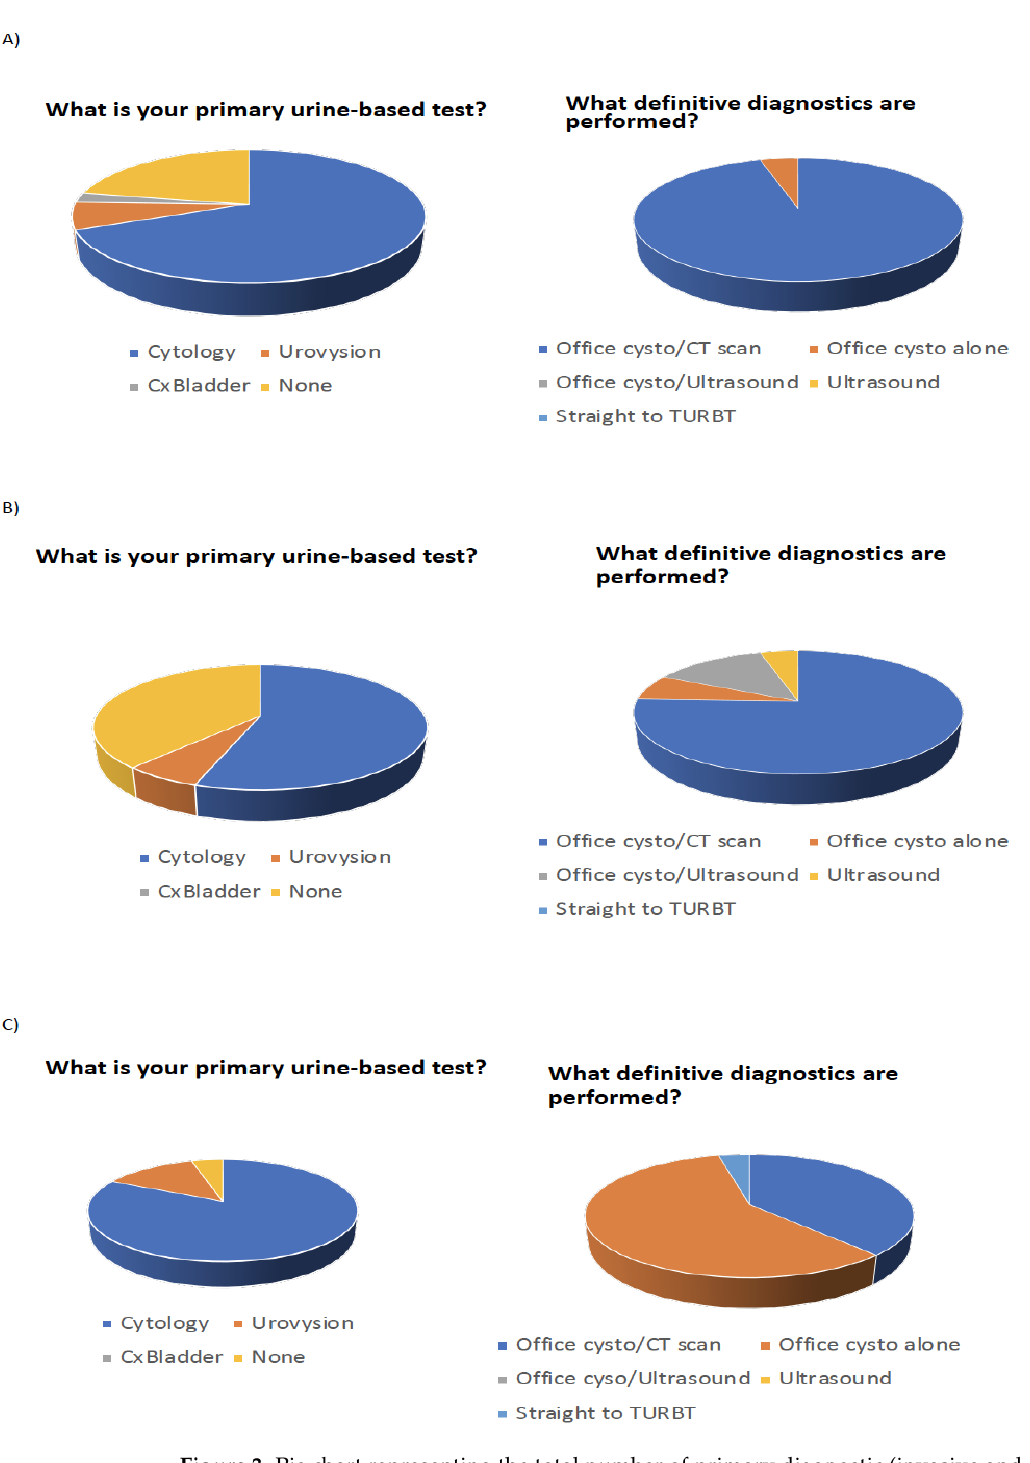
Figure 3. Pie chart representing the total number of primary diagnostic (invasive and non-invasive) tests performed for the evaluation of ( A ) gross hematuria, ( B ) microscopic hematuria, and ( C ) bladder cancer surveillance.